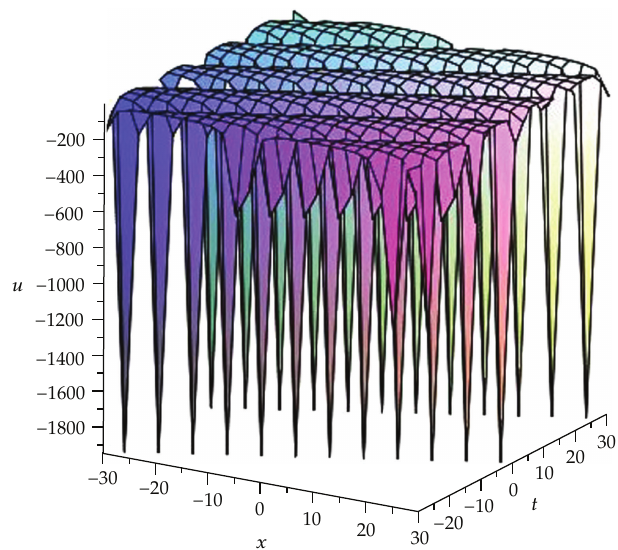
Figure 5: The solution u 3 of GSWW equation with k (cid:7) 0 . 3, c (cid:7) 2, α (cid:7) 3, β (cid:7) 1.